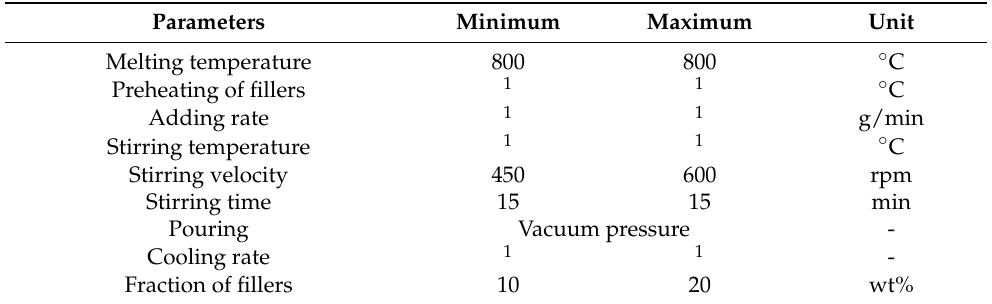
Figure 4. Modified stir casting Route 3 process scheme for MMSFs. Table 4. Range of values of parameters governing modified stir casting, Route 3 (MSC-3) process.